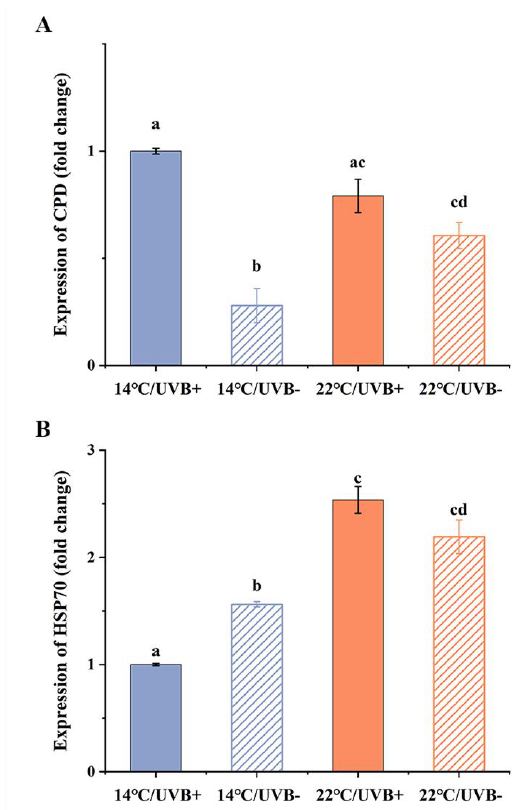
Figure 5. UVBR (solid bars) and UVBR – free (patterned bars) environments in combination with a 14 (blue bars) or 22 °C (red bars) temperature on the expression of CPD photolyase ( A ) and HSP70 ( B ) in Rana kukunoris tadpole tail tissue. Data are presented as means ± standard error. Lowercase letters above bars denote significant differences between groups.